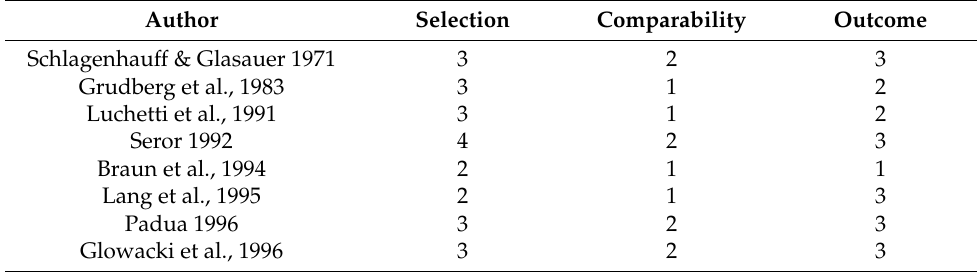
Table 1. NOS score of included